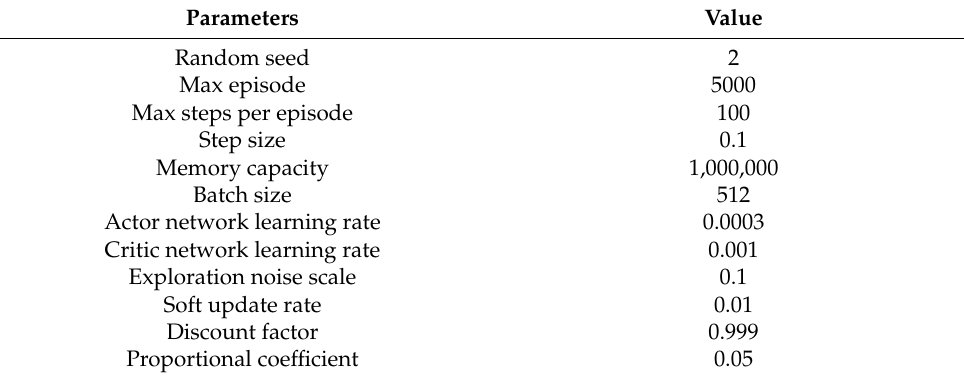
Figure 7. Structure of the neural networks: ( a ) actor neural network; and ( b ) critic neural network. Table 2. Hyperparameters of the KA-DDPG